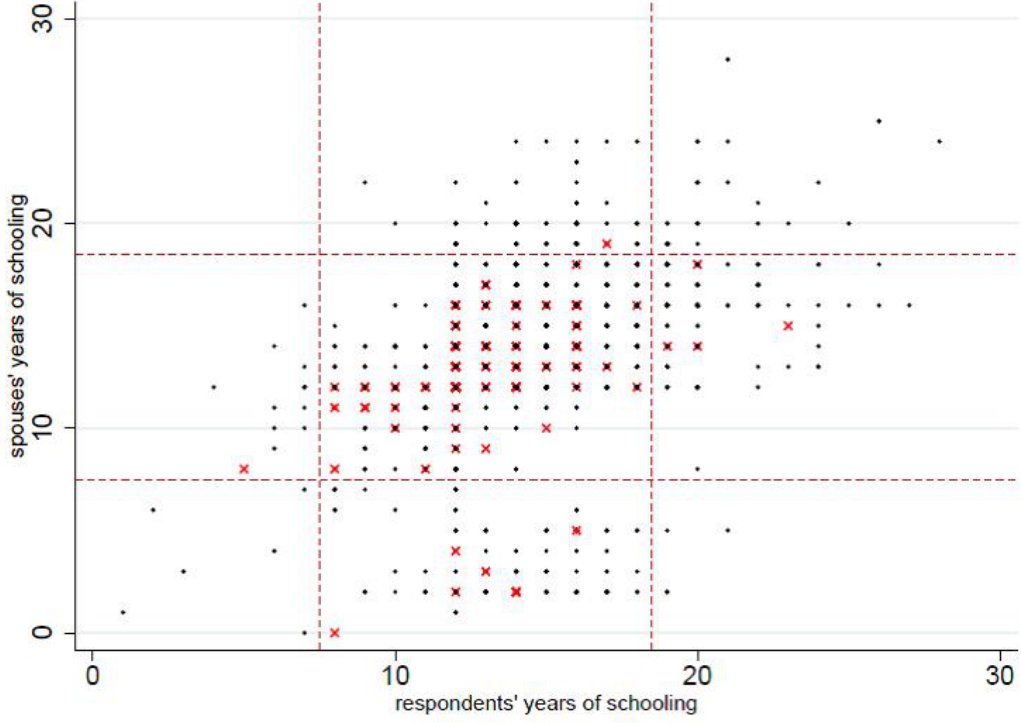
Figure 9. Divorce choice according to spouses’ education: red cross = divorced couple; back dot= married